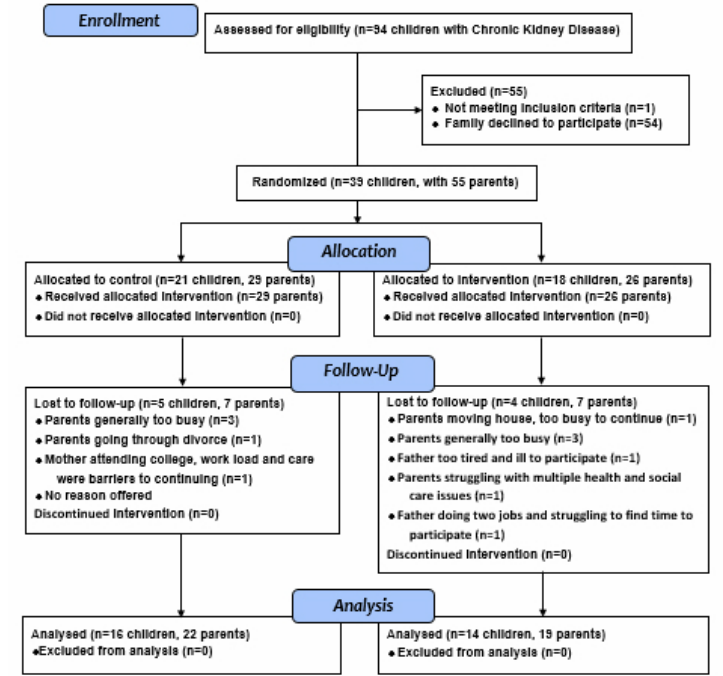
Figure 3. CONSORT diagram showing participant flow through